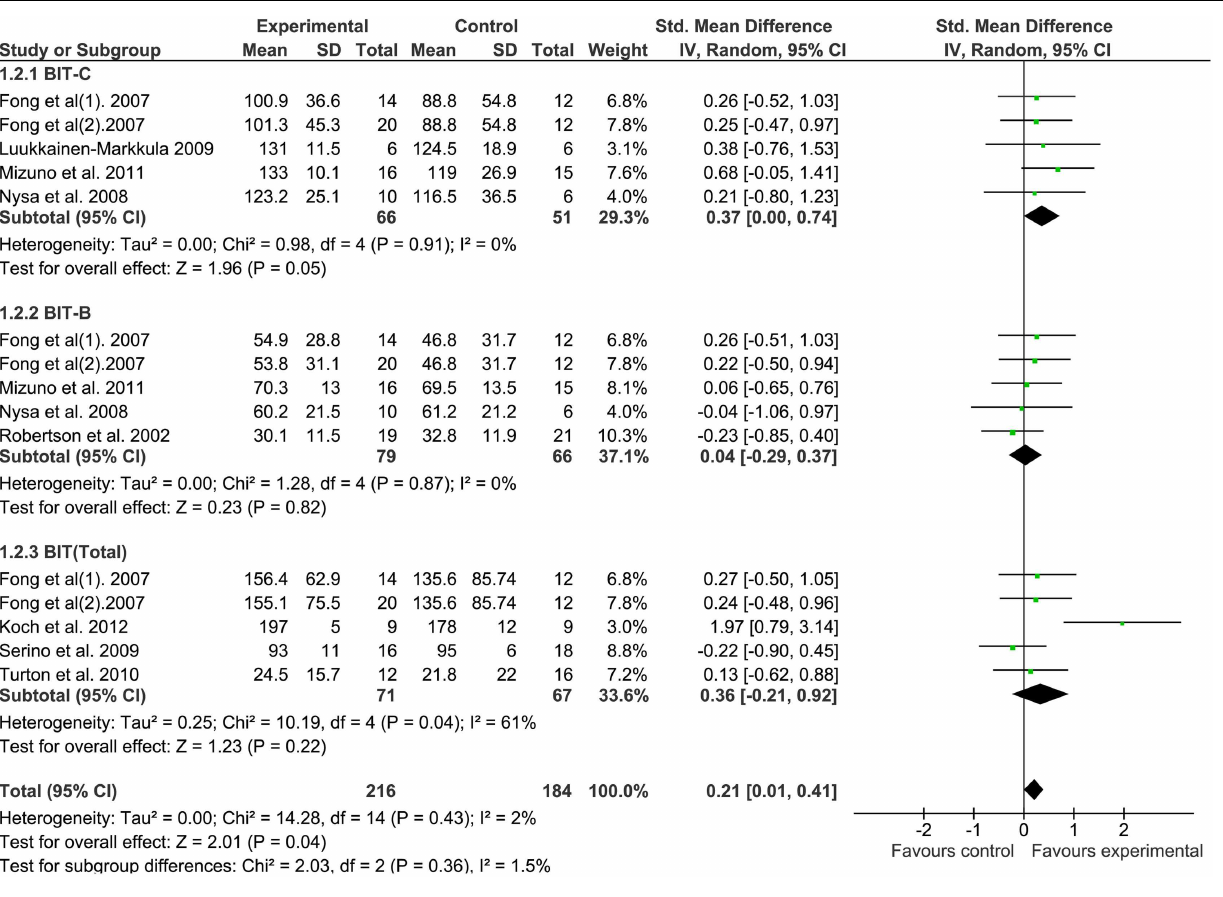
FIGURE 3 | Rehabilitation interventions versus any control, outcome: long-lasting effects